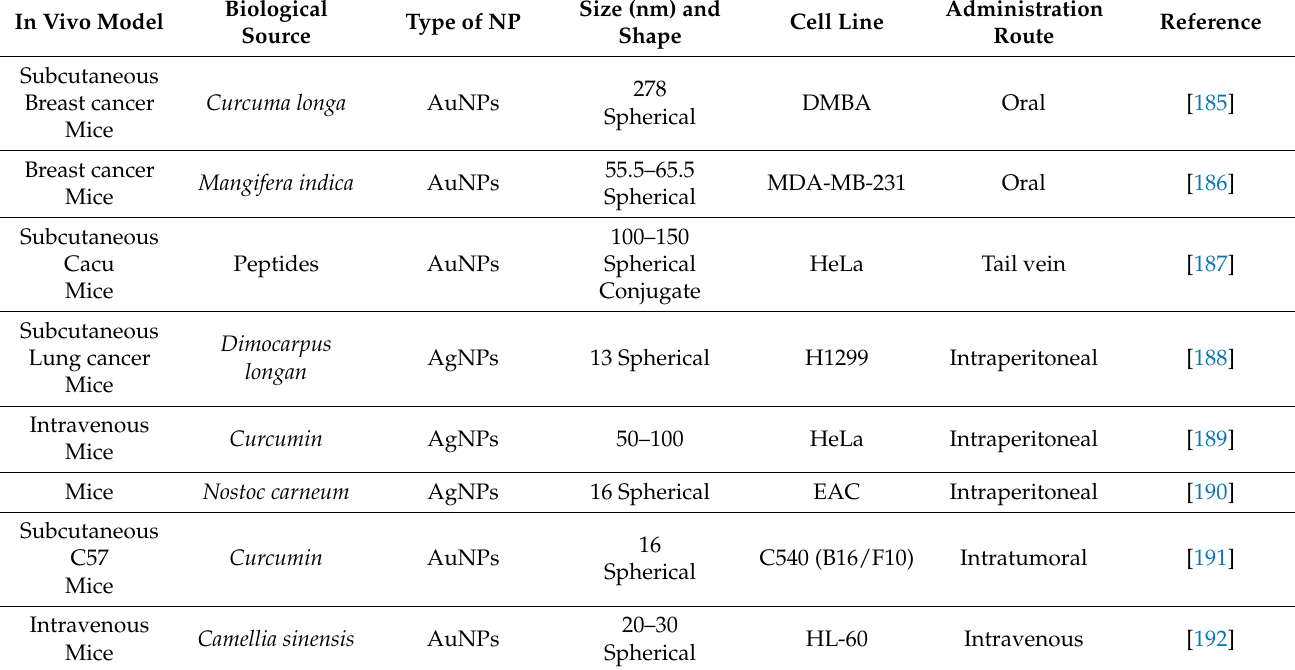
Table 4. Murine in vivo models used to evaluate the antitumor activity of green biogenic AuNPs and AgNPs.